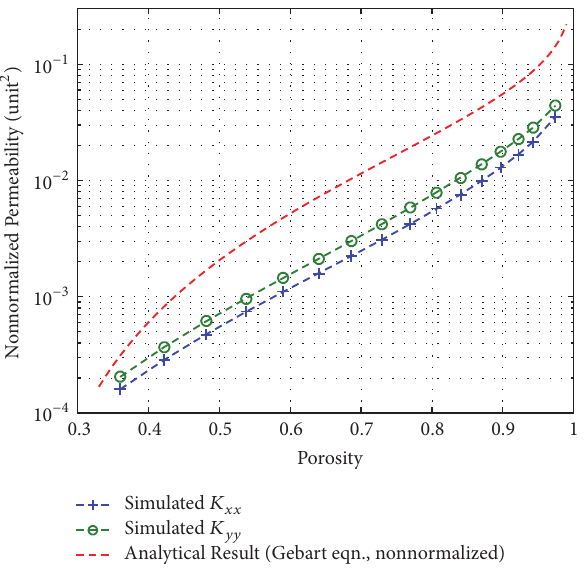
Figure 9: Permeability-porosity trend for staggered-array of squares.